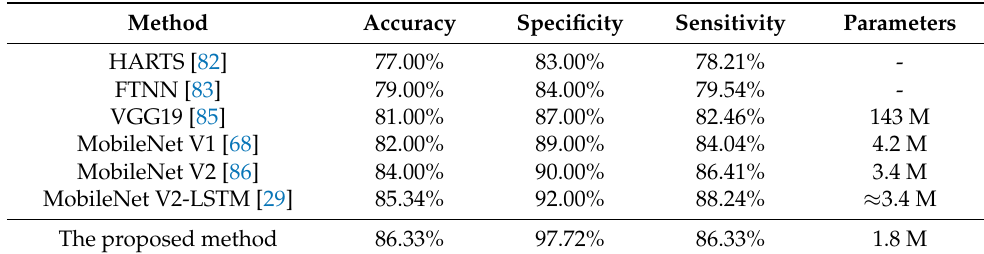
Figure 6. Bar chart results of various methods in the first experiment. Table 5. Comparison with different methods on the HAM10000 dataset in the second experiment